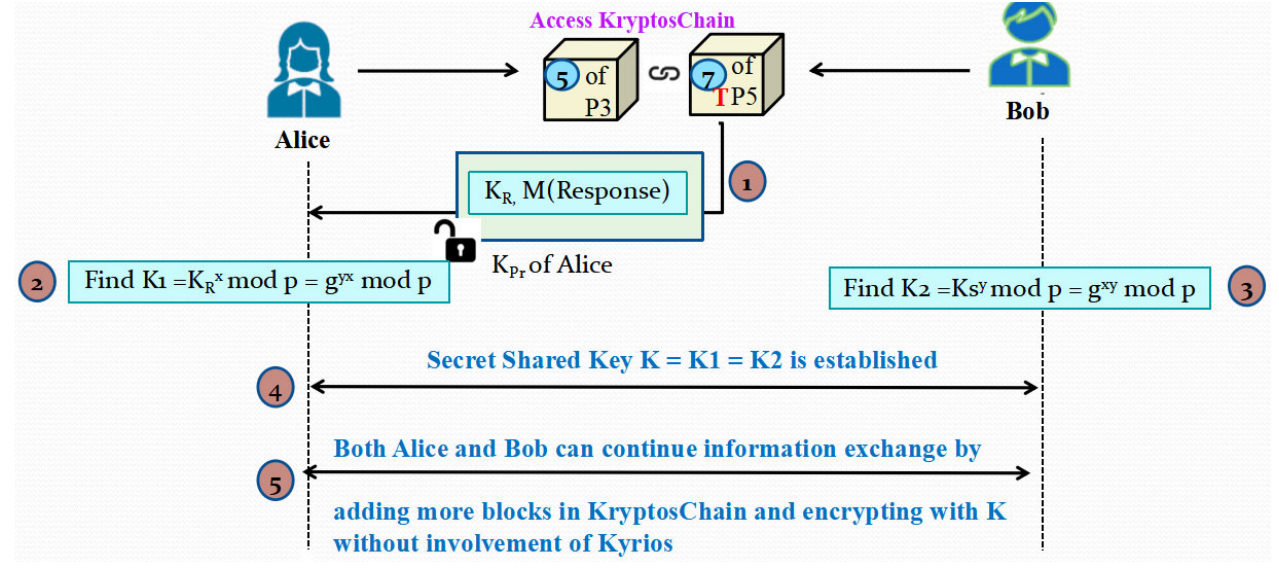
Figure 7. Illustration of Phase 6: Actual Information Exchange Process.